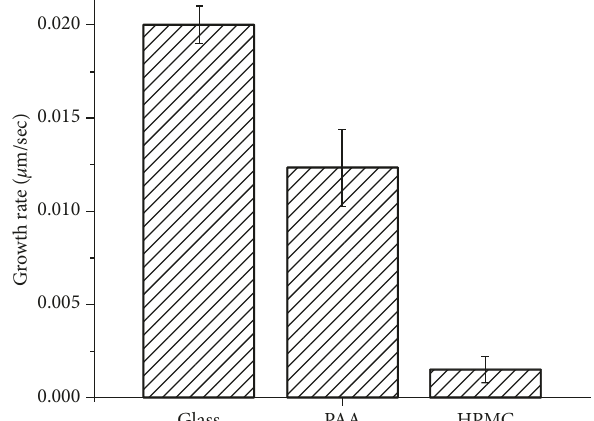
Figure 7: Interfacial crystal growth rate of APAP on glass, PAA, and HPMC